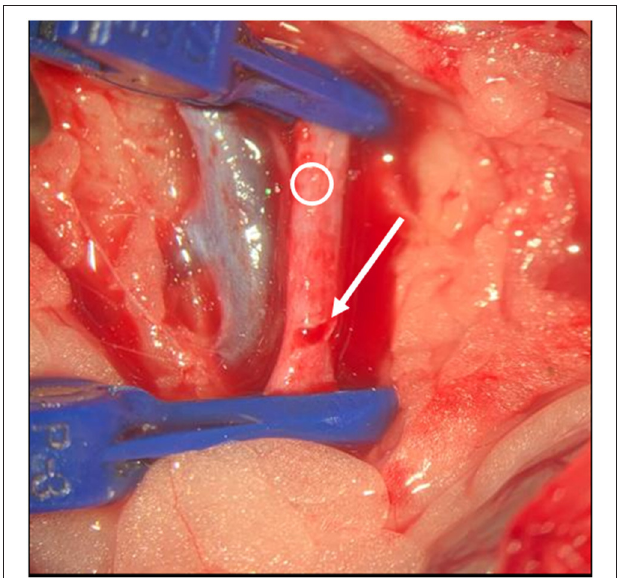
FIGURE 3 | Exemplary arterial pressure signal (A. Carotis) generated by a FOPS x-axis: mmHg, y-axis: time.